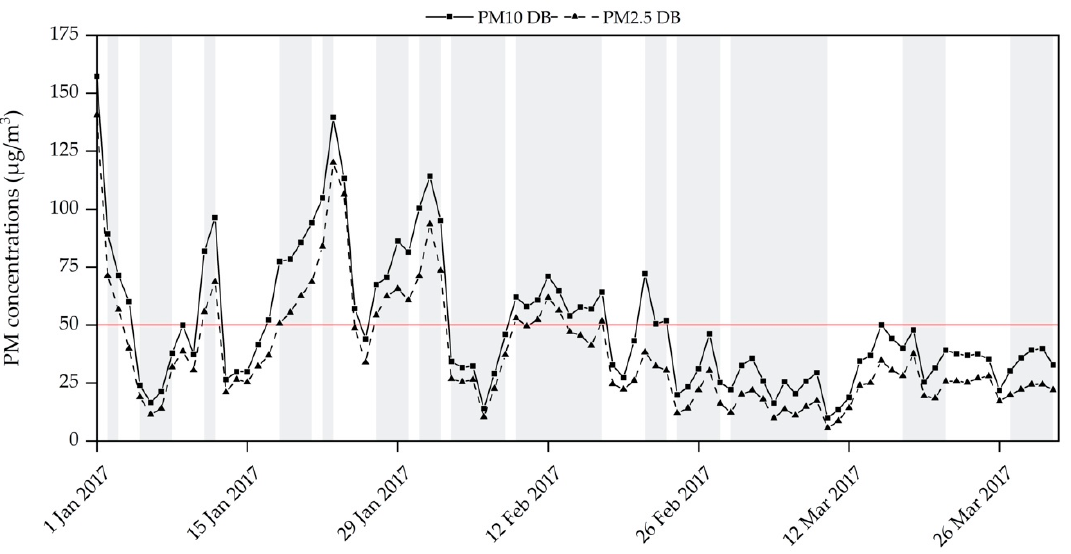
Figure 1. Daily average PM 10 and PM 2.5 concentrations observed at the urban sampling site Graz Don Bosco (DB). Grey shading marks selected time periods. For convenient reference, the red line marks the 50 µg/m 3 limit value set by the European Commission.